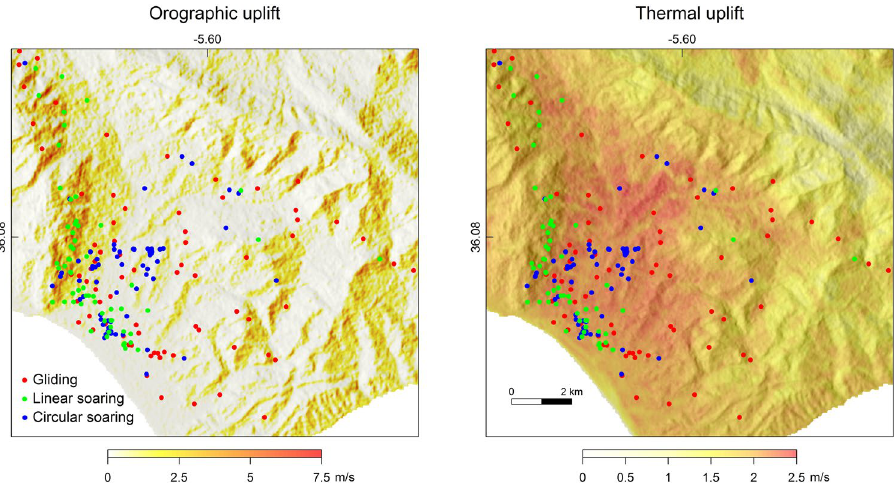
Figure 4. Correspondence between the uplift distribution and black kites flight modes (coloured dots). Only the part of the study area with higher bird use is shown. Orographic lift reflects levanter wind (direction: mean = 115.7°, SD = 0.02, range = 112–119; speed: mean = 10.4 m s-1, SD = 1.49, range = 3.7–12.7), when most of our tracking data was collected. Dots are positioned at the centroid of the respective track segment. Uplift maps are coloured from white to orange as higher uplift velocities were estimated (see methods). Light hill shading was added to illustrate interaction between topography and uplift. Uplift models used a LANDSAT image available at the USGS archive (http://earthexplorer.usgs.gov/) 64 , a DEM released by NASA and the USGS (at http://gdex.cr.usgs.gov/gdex/) 60 and were developed with the software ArcGIS 61 (see methods section for further